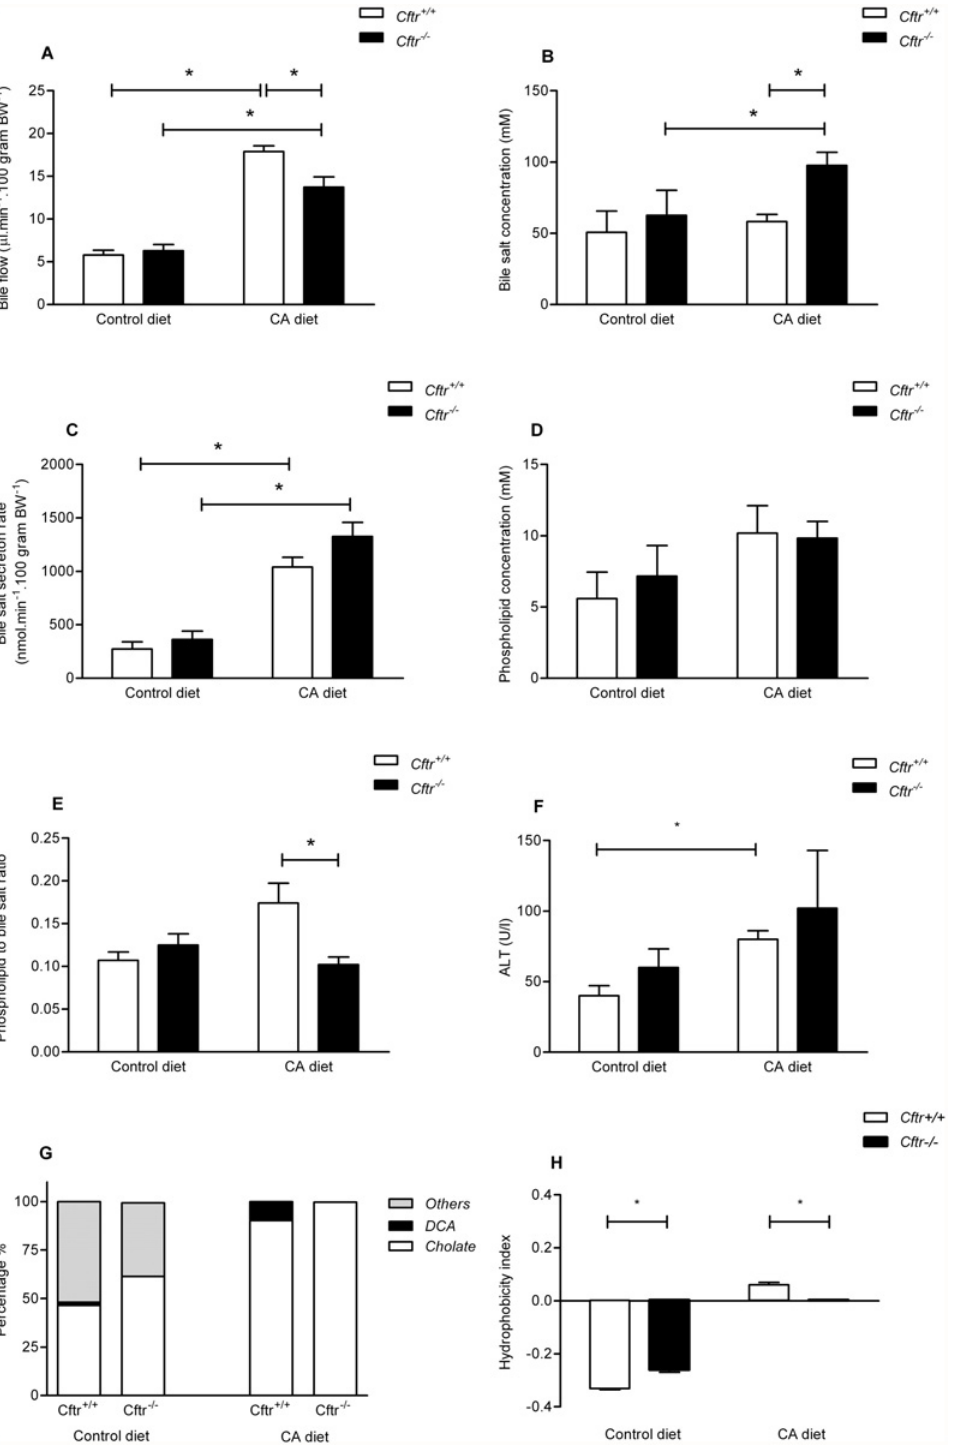
Fig 2. Biliary parameters and bile composition of Cftr knockout mice (Cftr -/- ) and controls, fed a control diet or a cholic acid (CA) containing diet for 3 weeks. Biliary bile flow (A), bile salt concentration (B), bile salt secretion rate (C), phospholipid concentration (D), phospholipid-to-bile salt ratio (E), serum ALT levels (F), percent contribution to total biliary bile salts of cholate, deoxycholate and others (chenodeoxycholate, ursodeoxcholate, α -muricholate and β - muricholate) (G), and, Heuman index of biliary bile salts representing the hydrophobicity (H), in Cft r knockout mice ( Cftr -/- ) and control littermates ( Cftr +/+ ) after a control or 0.5%-CA (wt/wt) chow diet for three weeks. Data are presented as means ± SEM or percentage (panel G) of N = 5 – 7 mice per group. * P-value <